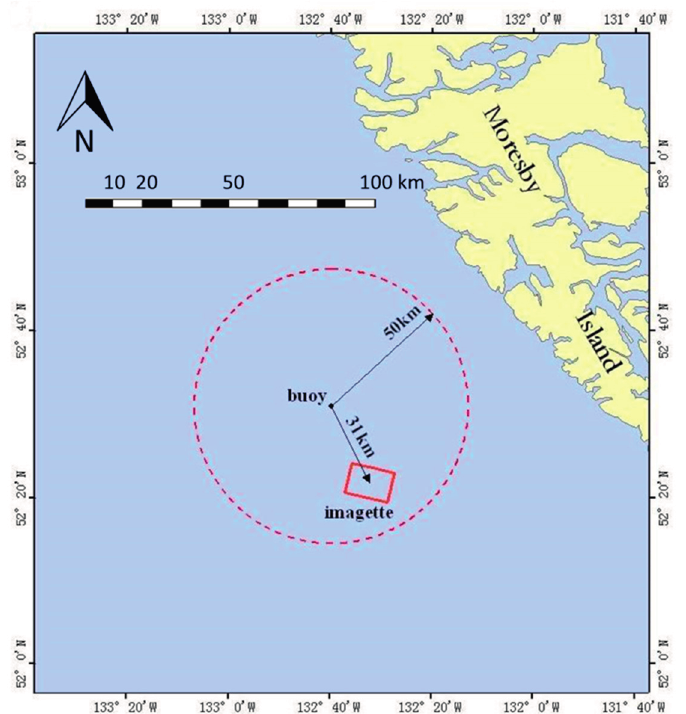
Figure 3. Collocation example of Envisat ASAR and NDBC buoy when the maximum collocation distance is set to be 50